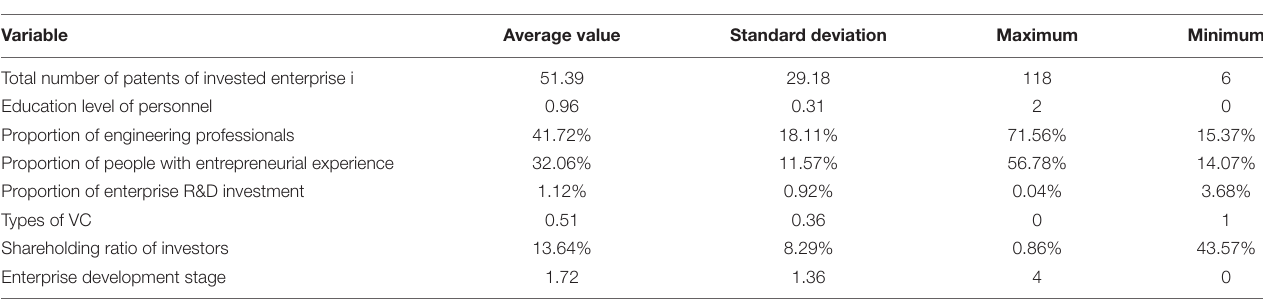
TABLE 2 | Descriptive statistics of all variables in the model.